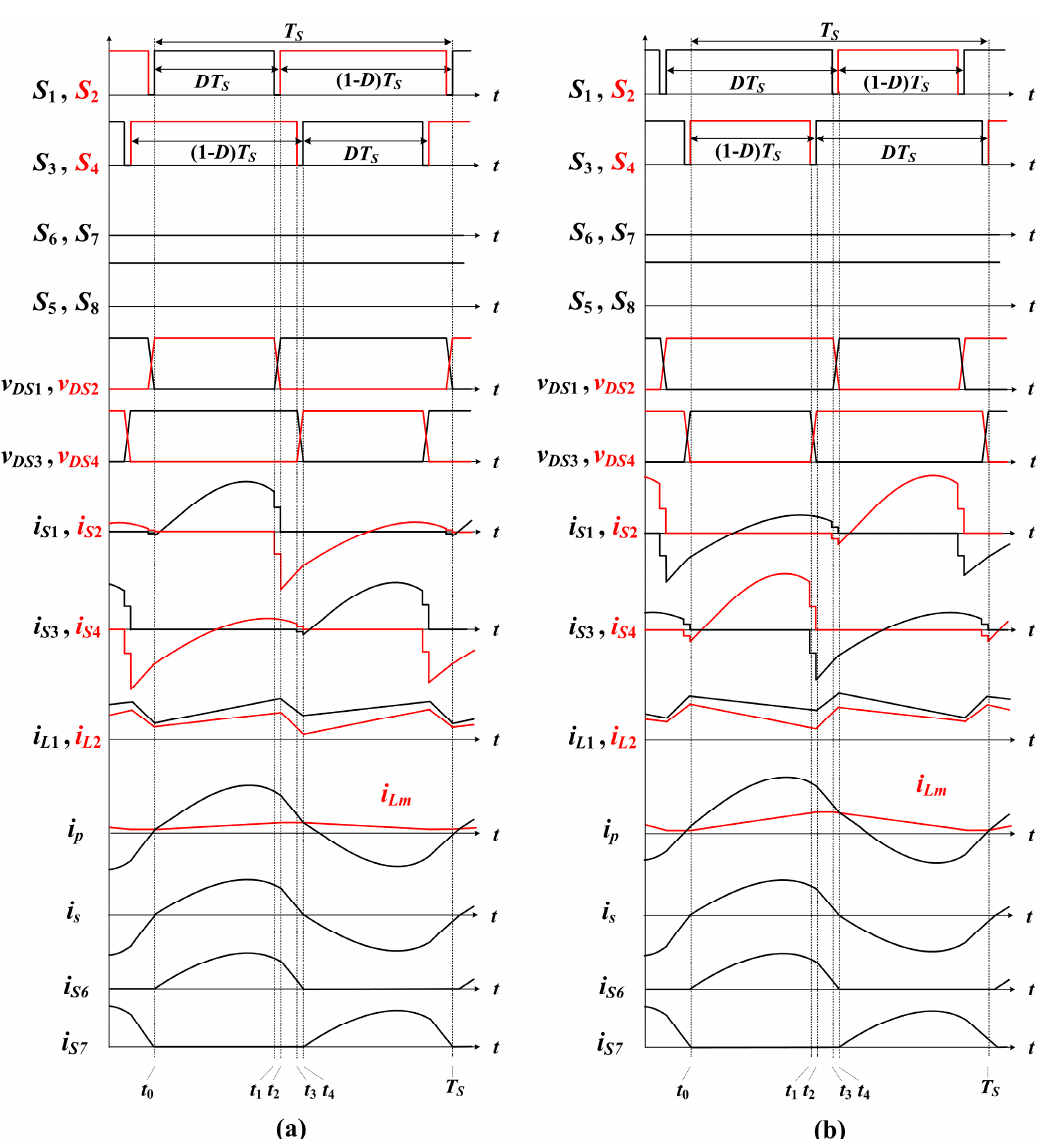
Figure 3. Operating waveforms of the proposed micro-inverter for ( a ) D ≤ 0.5 and ( b ) D > 0.5.